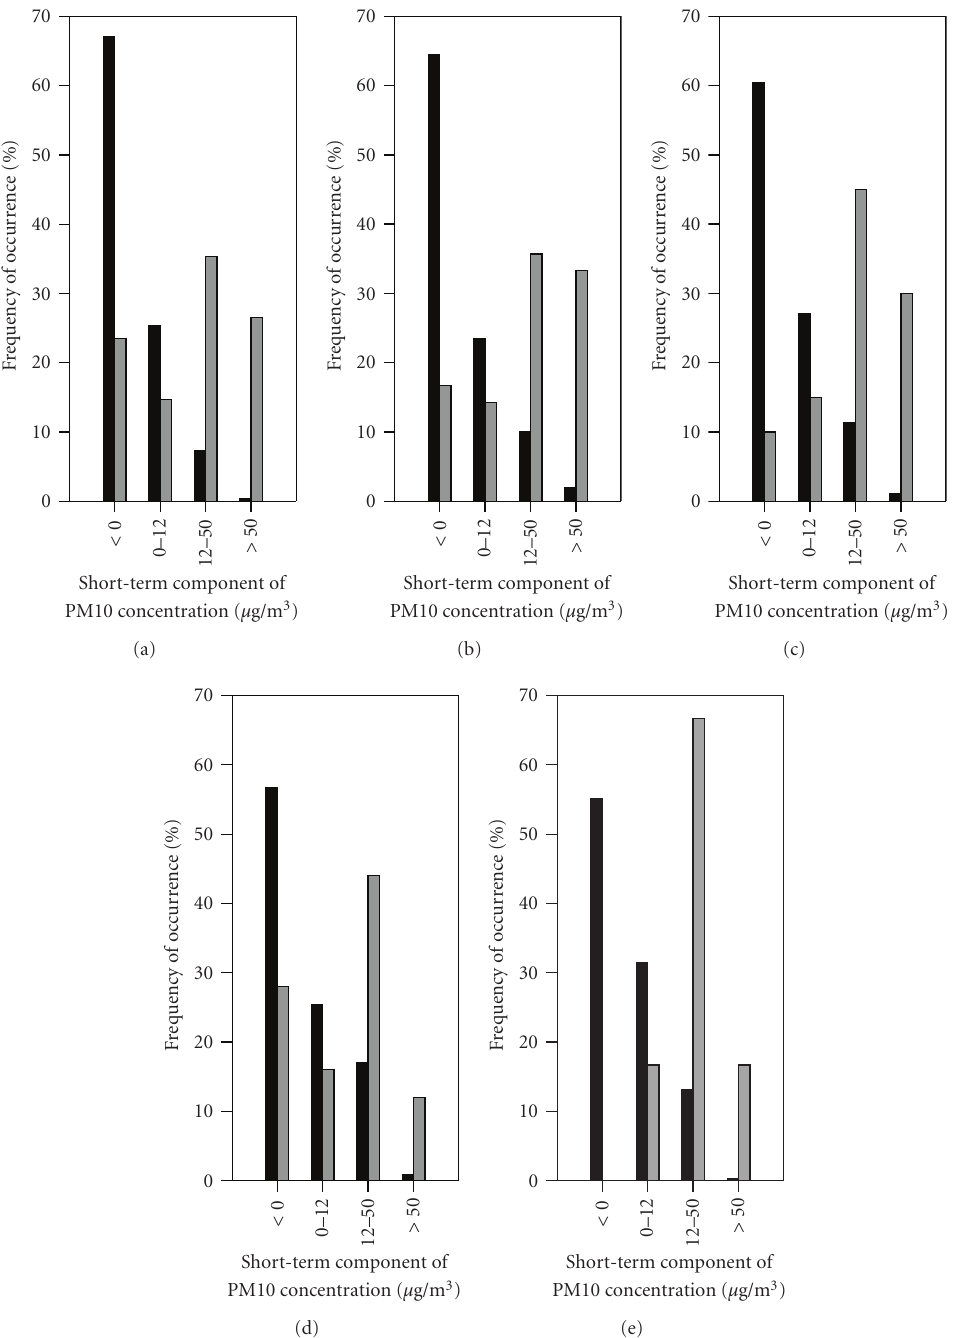
Figure 3: Frequency distribution of the short-term component of the observed PM10 concentrations at (a) Finokalia, (b) Heraklion, (c) Thrakomakedones, (d) Volos, and (e) Panorama; Grey bars correspond to the days when a dust outbreak is identified, while black bars correspond to the rest of the